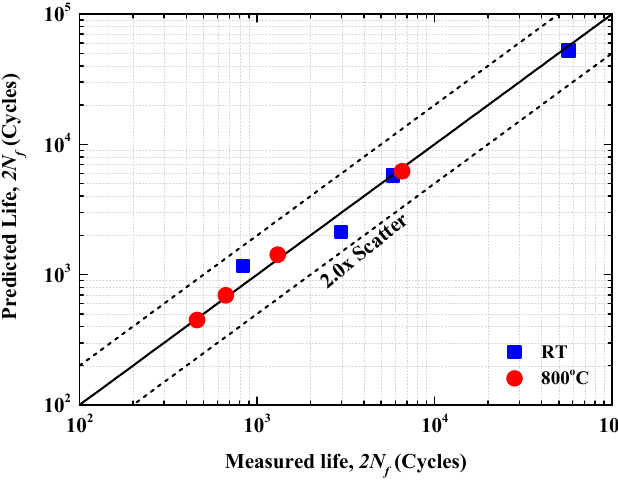
Figure 9. Validation of the predicted lives by Coffin ‐ Manson relationship for Alloy 617 weldments.